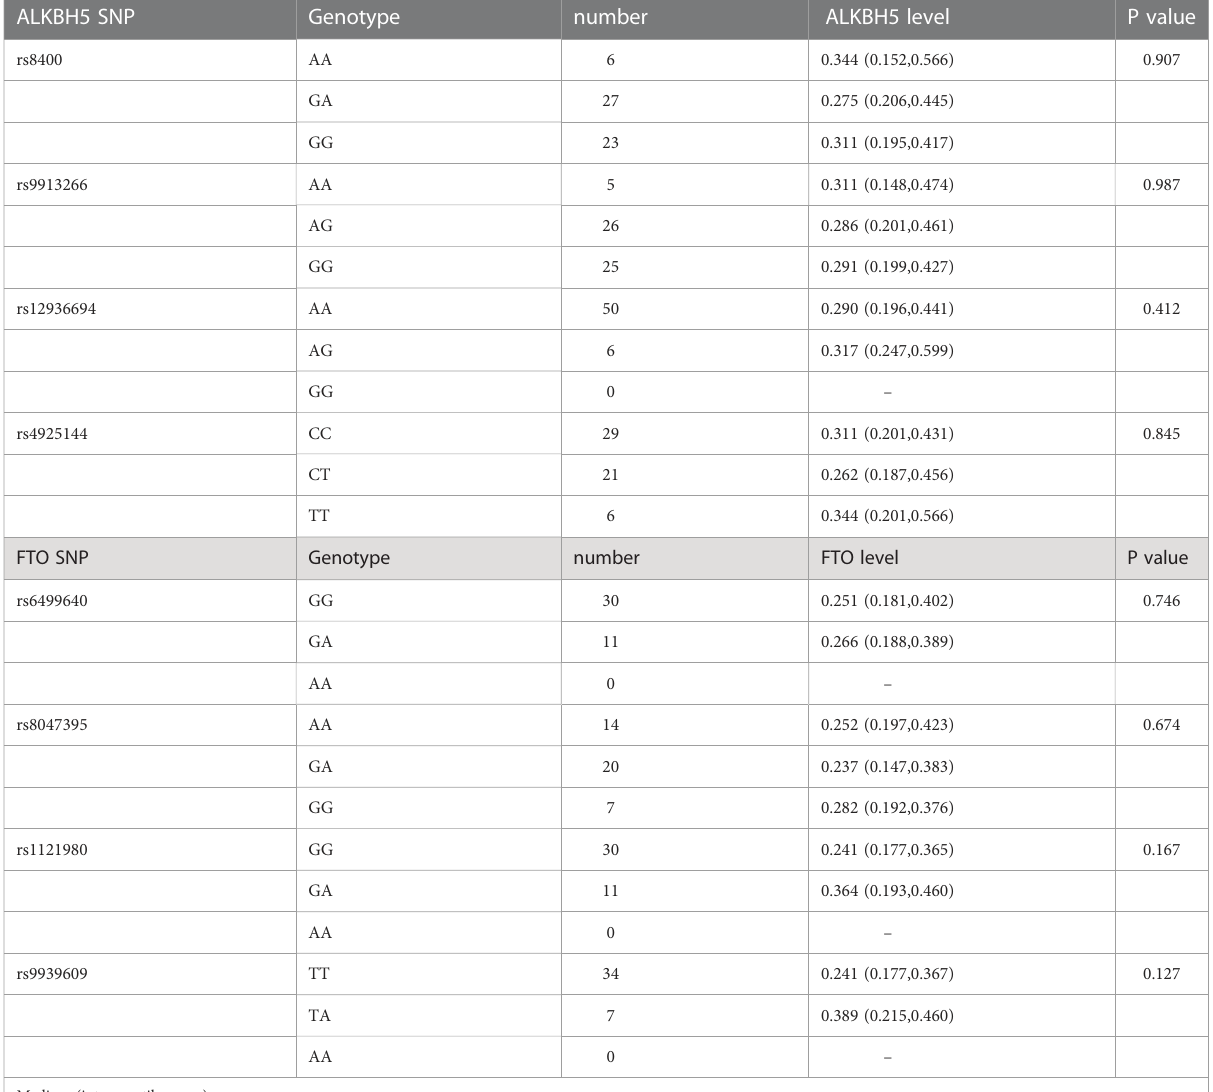
Median (interquartile